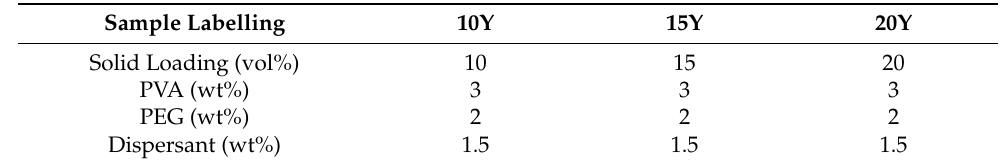
Table 1. Composition of the suspensions with varying solid loading (content of additives in wt% with respect to ceramic